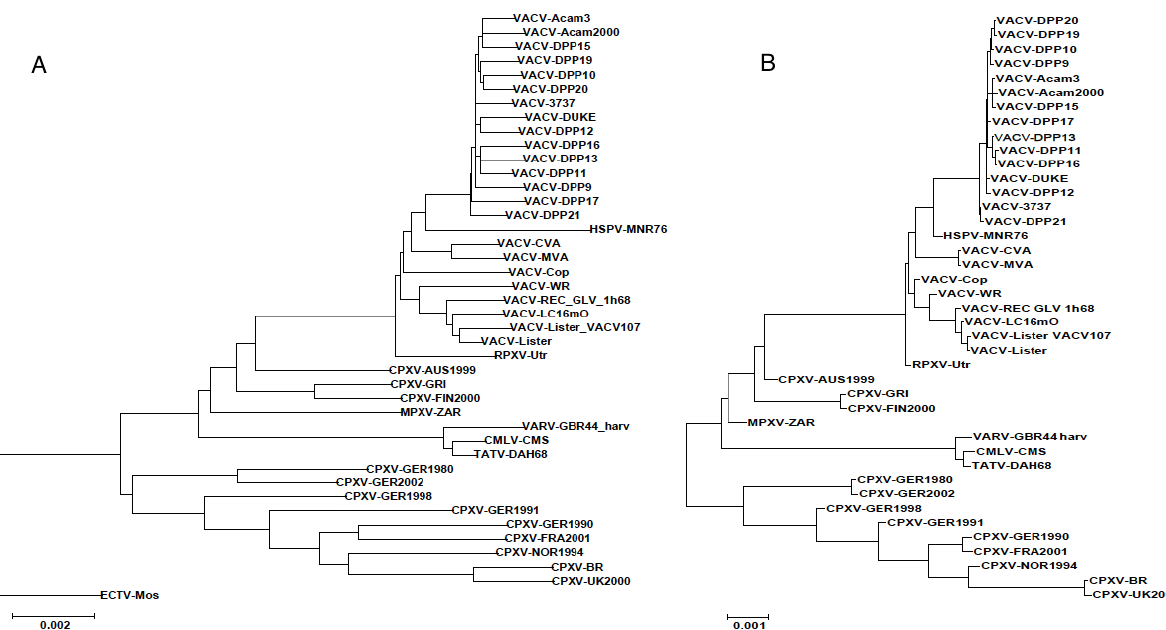
Figure 2. Modified orthopoxvirus phylogenetic trees. Maximum-likelihood trees were created based on the Tamura-Nei method. ( A ) “snipped” tree; unique SNPs were removed from the multiple sequence alignment (MSA) prior to creating the tree; ( B ) Synthetic sequences, “snipped” tree. ECTV-Mos was not included due to limitations of the program. Scale bars refer to nucleotide substitutions per